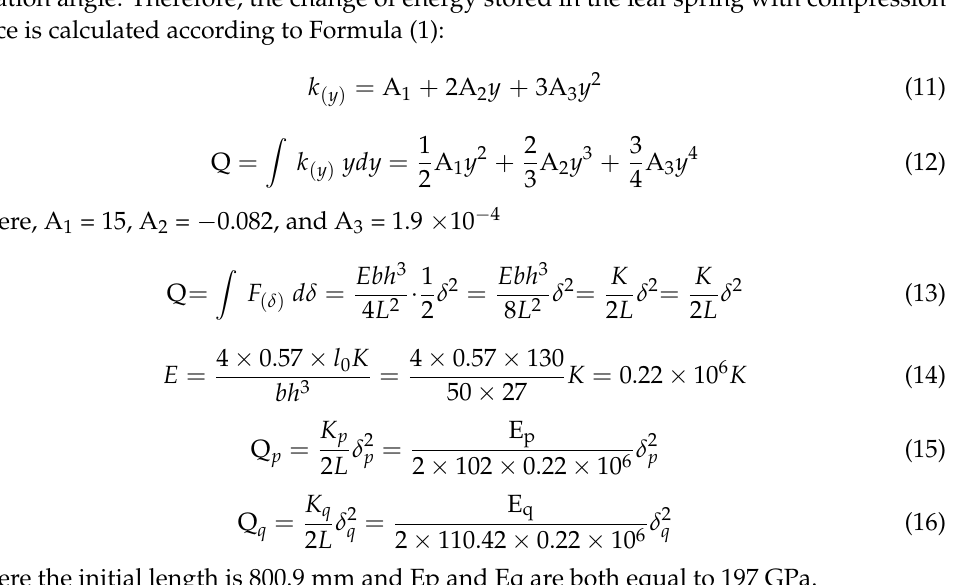
Figure 8. Effect of the 𝐸̅ and F 𝑥 of the bionic leg under different compression forces and initial lengths.